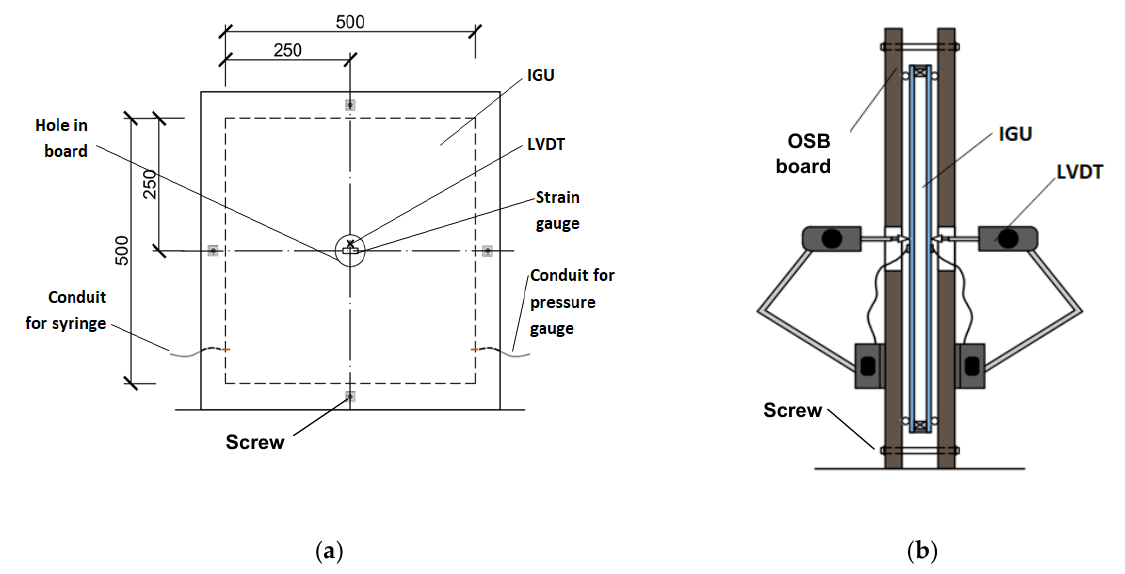
Figure 2. Scheme of the test set-up: ( a ) side view; ( b ) cross-section. A single test series consisted of injecting or withdrawing a defined air volume into/from the IGU gap. During the test, the following quantities were measured: over- or under-pressure in the gap, out-of-plane deflection of the panes, and stress in the glass in the center of the model. After the gas was injected/withdrawn into/from the gap, the meas- urements were carried out for 5 min. The test campaign consisted of eight test series, in- cluding injecting and withdrawing the air from the gap ranging from 50 mL to 200 mL with a 50 mL interval. Five repetitions were performed for each test series.